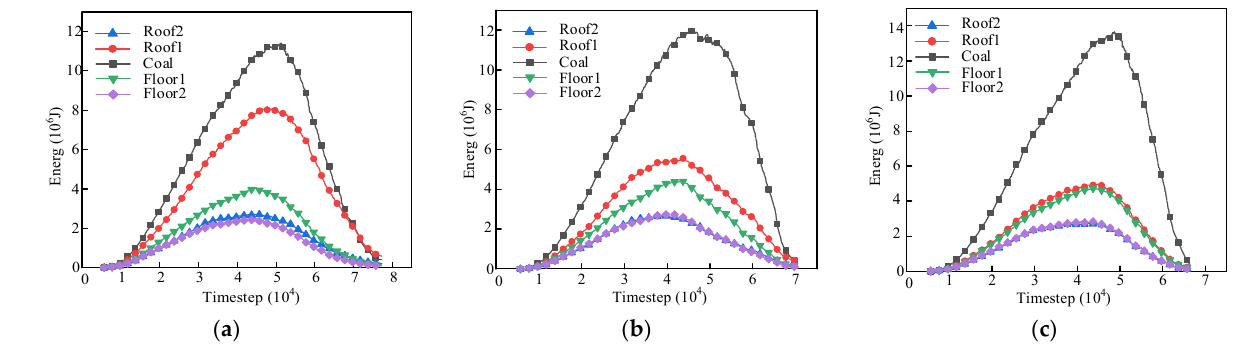
Figure 11. Partition strain energy evolution law of roadway surrounding rock. ( a ) RSR-1; ( b ) RSR-2; ( c ) RSR-3.